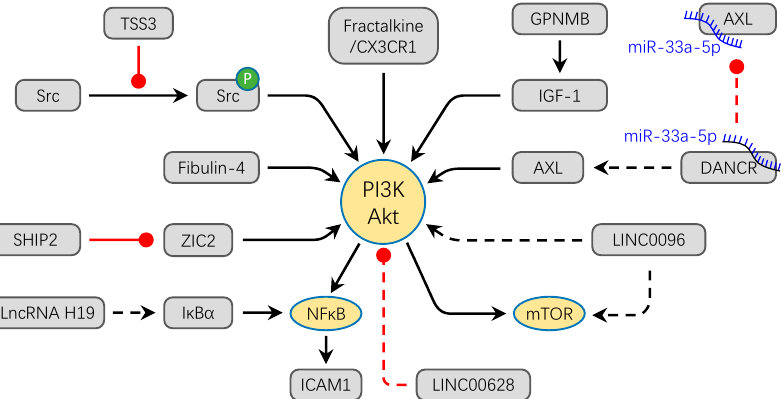
Figure 2. The PI3K / Akt signaling pathway converges to facilitate the progression OS. Most factors Figure 2. The PI3K/Akt signaling pathway converges to facilitate the progression OS. Most factors directly activate PI3K / Akt signaling pathway to promote the migration and invasion of OS. For example, directly activate PI3K/Akt signaling pathway to promote the migration and invasion of OS. For overexpression of Fibulin-4, Fractalkine / CX3CR1, ZIC2, LINC0096, and lncRNA H19 promote the example, overexpression of Fibulin-4, Fractalkine/CX3CR1, ZIC2, LINC0096, and lncRNA H19 osteosarcoma metastasis through the activation of PI3K / Akt signal pathway. Meanwhile, GPNMB and promote the osteosarcoma metastasis through the activation of PI3K/Akt signal pathway. Meanwhile, DANCR / miR-33a-5p activate the PI3K / Akt pathway by promoting the expression of IGF-1 and AX, GPNMB and DANCR/miR-33a-5p activate the PI3K/Akt pathway by promoting the expression of respectively. TSSC3 inhibits the phosphorylation of Src to activate the PI3K / Akt signaling pathway. IGF-1 and AX, respectively. TSSC3 inhibits the phosphorylation of Src to activate the PI3K/Akt Conversely, overexpression of LINC00628 inhibits the phosphorylation of PI3K and Akt. The solid lines signaling pathway. Conversely, overexpression of LINC00628 inhibits the phosphorylation of PI3K refer to protein molecules and the dotted lines refer to non-coding RNAs in this figure. Black arrows and Akt. The solid lines refer to protein molecules and the dotted lines refer to non-coding RNAs in show the promotion of molecules, while red dots show the inhibition of